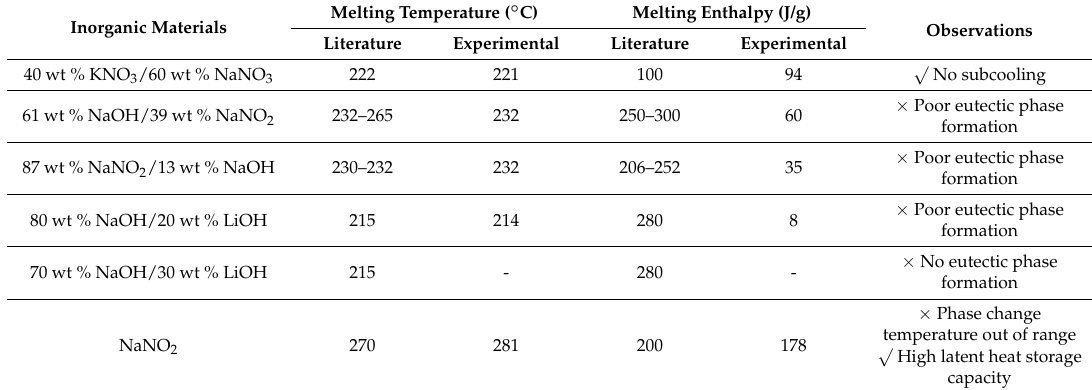
Table 7. Differential scanning calorimeter (DSC) results of inorganic salts and eutectic mixtures [8–12,14,17]. Melting Temperature ( ◦ C) Melting Enthalpy (J/g) Inorganic Materials